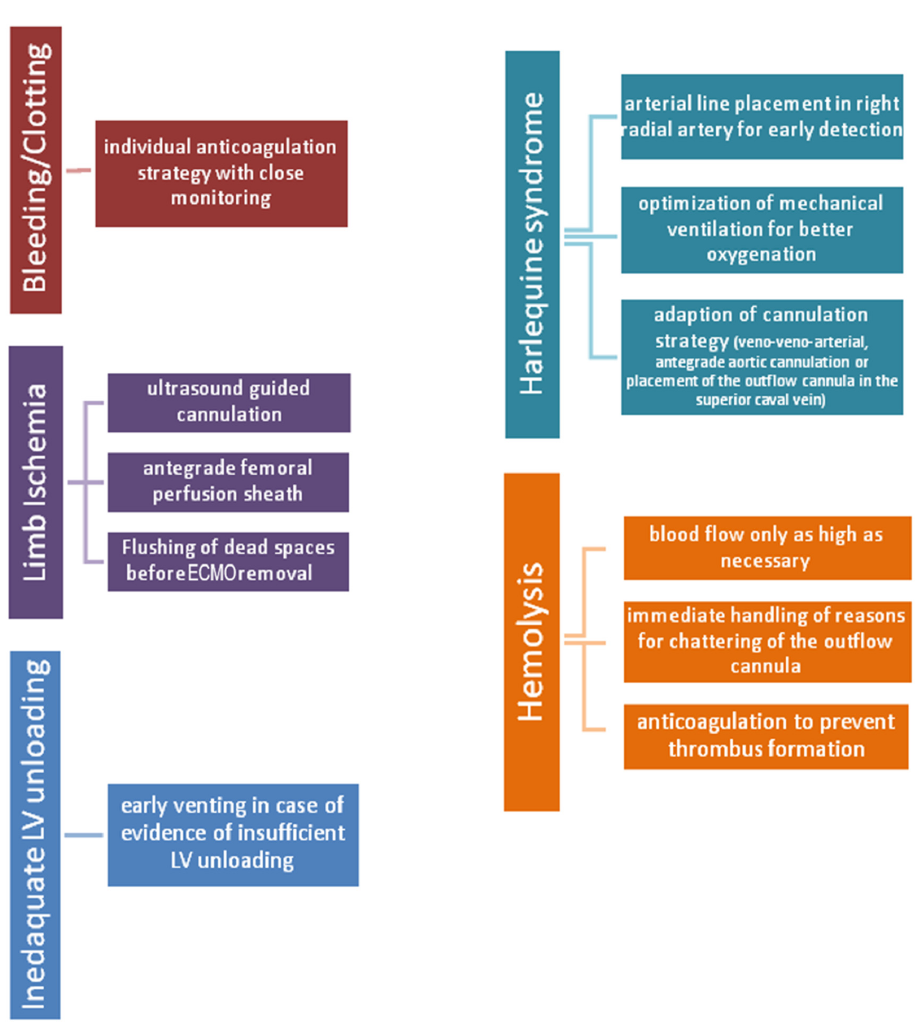
Figure 3. Strategies to avoid potential complications of VA-ECMO therapy. ECMO = extracorporeal membrane oxygenation; LV = left ventricular.